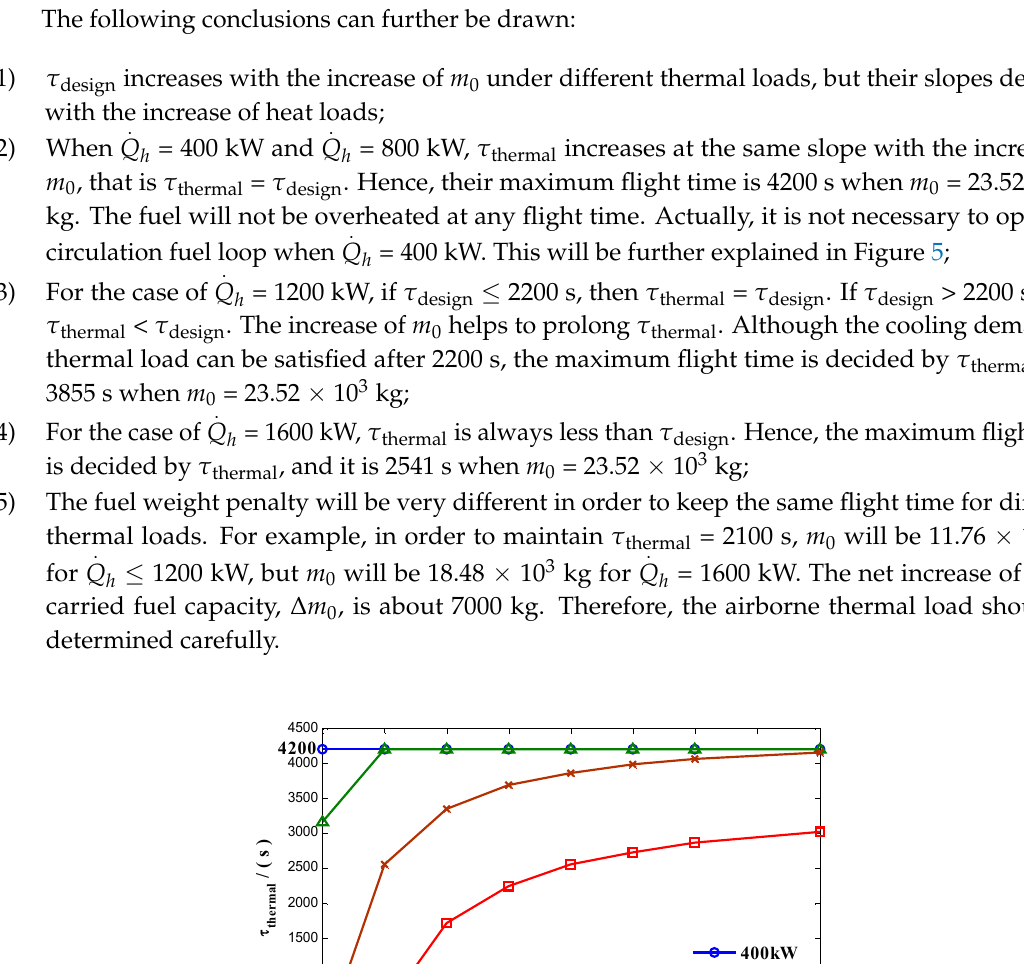
0 , τ thermal and τ design .